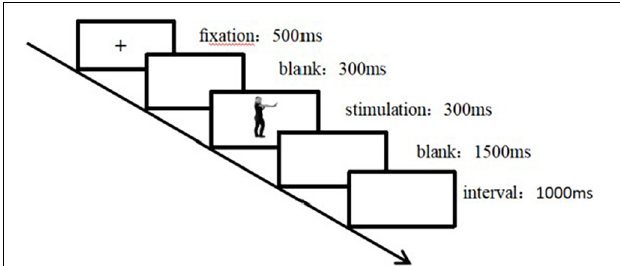
FIGURE 2 | Flowchart of experimental trial procedure. Each trial started with a 500-ms fixation cross “+,” slightly above the center of the screen, which is the “chest height” of the body in the picture. After 300 ms of a blank screen, 300 ms of target stimulation was presented, followed by 1,500 ms of a blank screen. If there was no response within 1,500 ms, the blank screen disappeared automatically. After a 1,000-ms interval, the next trial